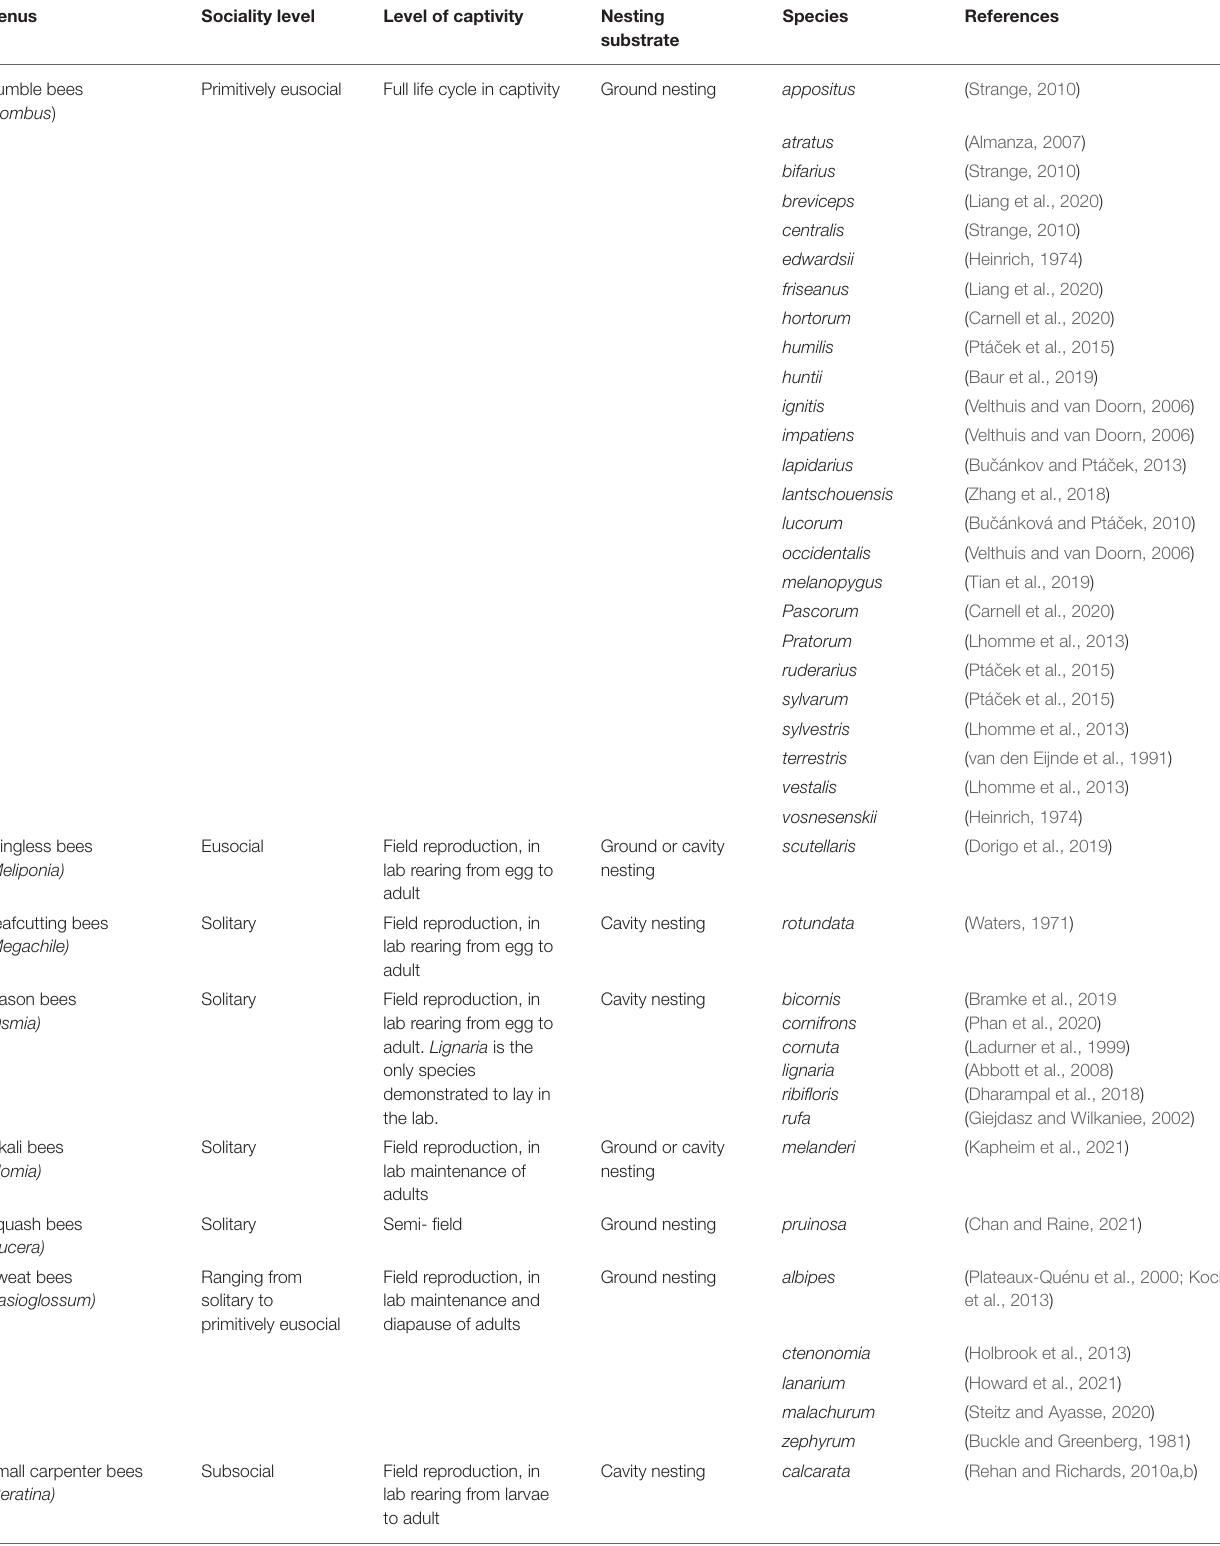
TABLE 1 | List of wild bee species that have been successfully propagated in controlled lab or semi-field settings and have the potential to be used for controlled assays of foraging preferences and impacts of diets on health, development, and fitness.